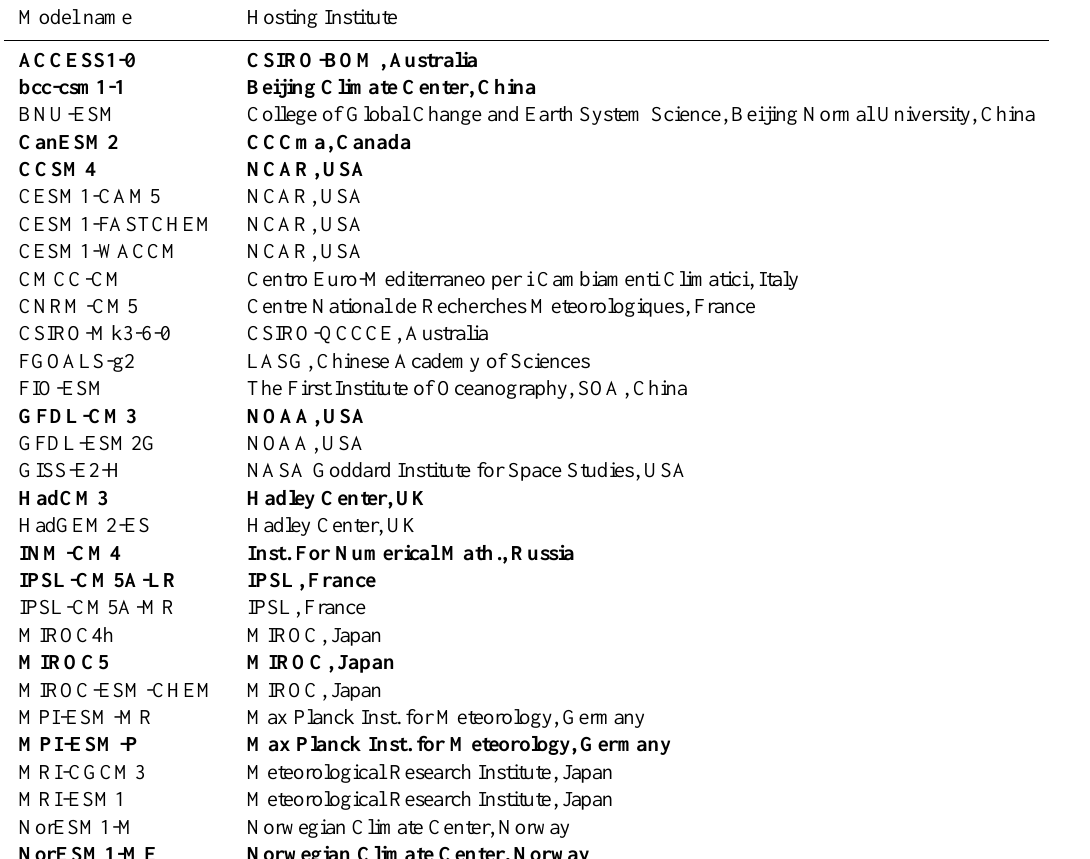
Table 3. List of CMIP5 models used for the “Multi-model mean larger set of models” plot in Fig. 1. CMIP5 models in bold font are the models used for the rest of the